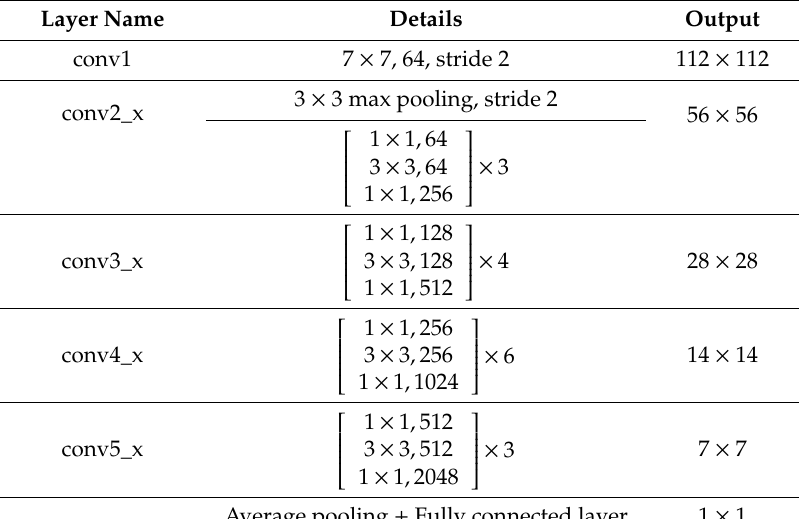
Table 1. The layers of Resnet-50